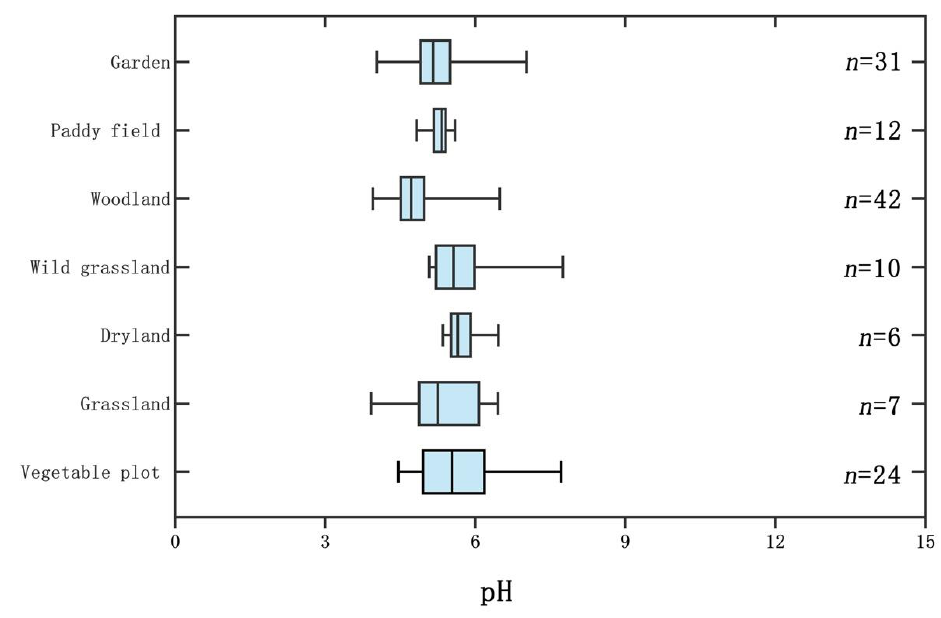
Figure 2. Box plot of soil pH under different land-use practices in the study area.